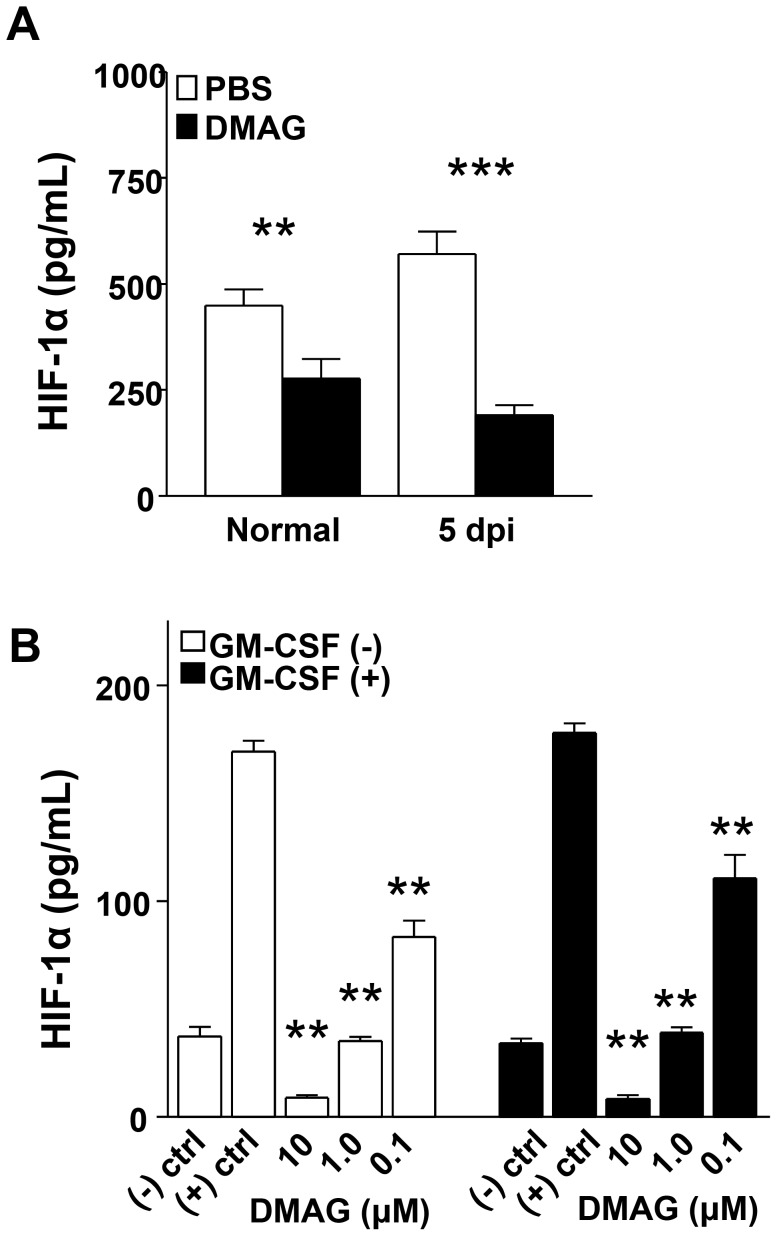
DMAG-induced inhibition of HIF-1α expression.As a complementary approach to siRNAHIF-1α treatment, DMAG-induced inhibition of HIF-1α levels in vivo (A) was examined by ELISA in the normal (uninfected) cornea and at 5 days after ocular infection. HIF-1α protein was significantly reduced at both time points compared to PBS-treated controls. DMAG treatment was tested in vitro (B) using peritoneal-elicited PMN (+/− GM-CSF). Cells were stimulated with P. aeruginosa 19660 (2.5∶1 ratio of bacteria∶cells) +/− DMAG treatment (10, 1.0, 0.1 µM) for 18 hours, then HIF-1α protein levels from supernatants were determined by ELISA. Results showed that HIF-1α was significantly reduced after DMAG treatment at all three concentrations compared to positive controls (bacteria only). Negative control (no DMAG, no bacteria) showed baseline expression of HIF-1α protein. Data represent three independent experiments. *P<0.05, ** P<0.01, *** P<0.001.